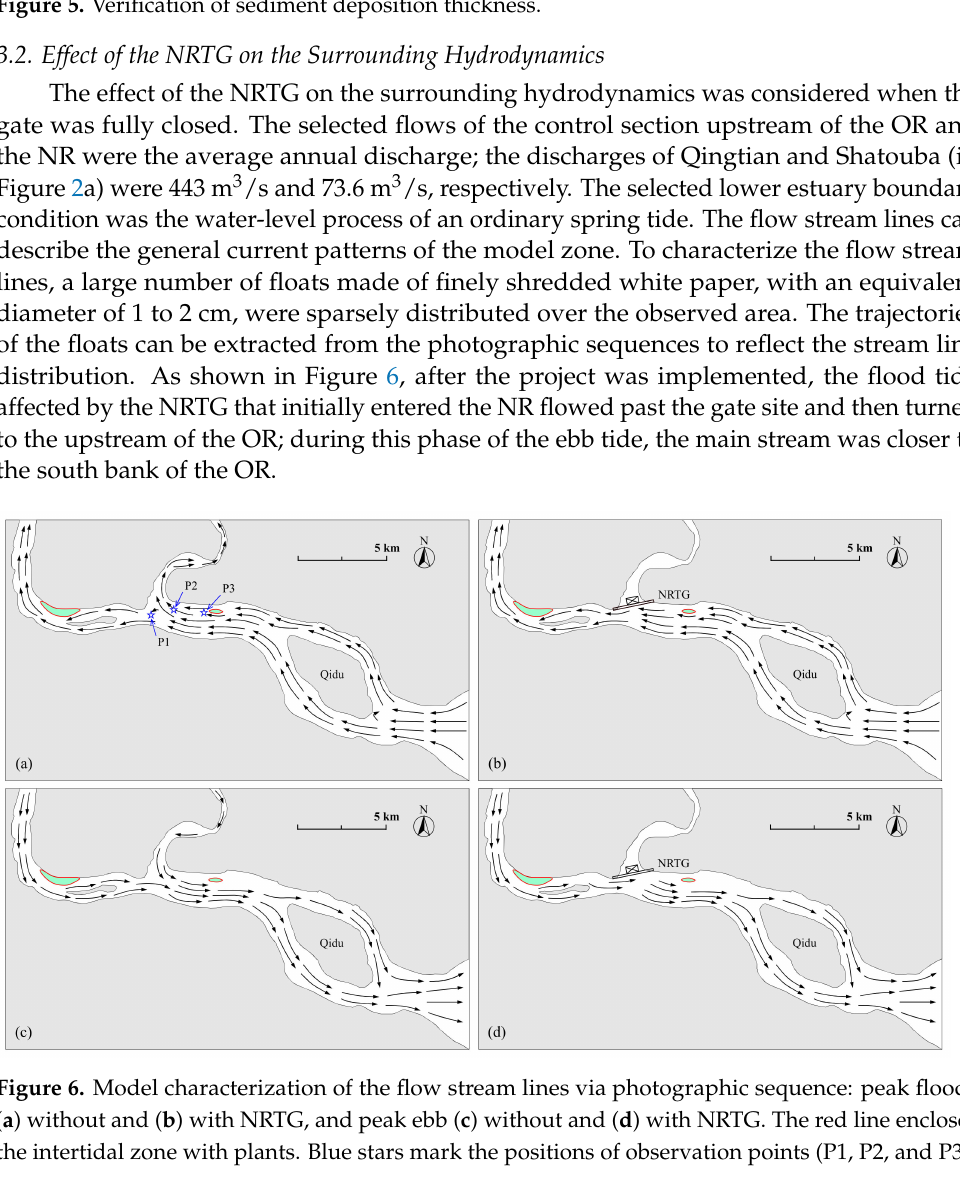
Figure 5. Verification of sediment deposition thickness.